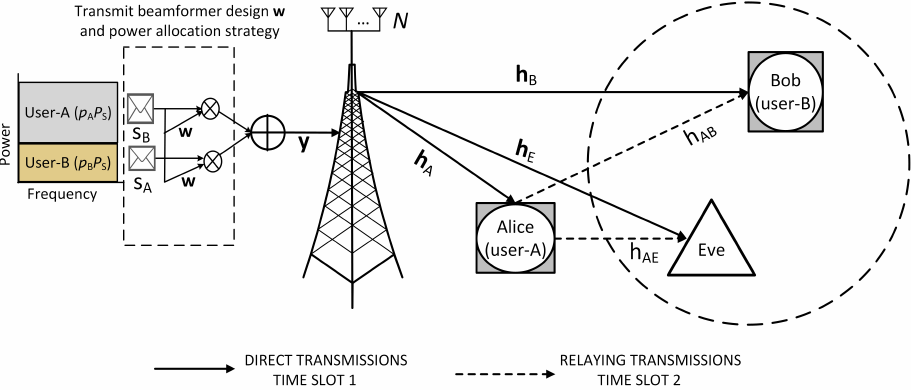
Figure 1. System model of a secure cooperative multiple-input single-output non-orthogonal multiple-access (MISO-NOMA)